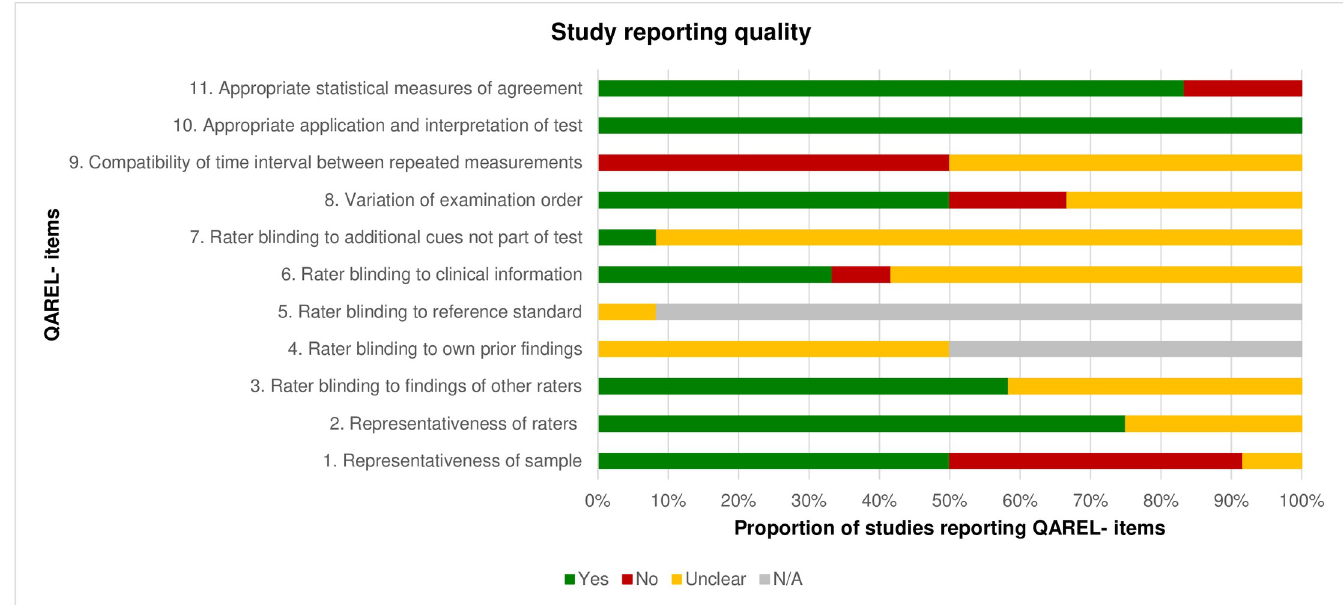
Fig 4. Assessment of study reporting quality of the included reliability studies on clinical assessments using the QAREL- checklist. N/A = not applicable.